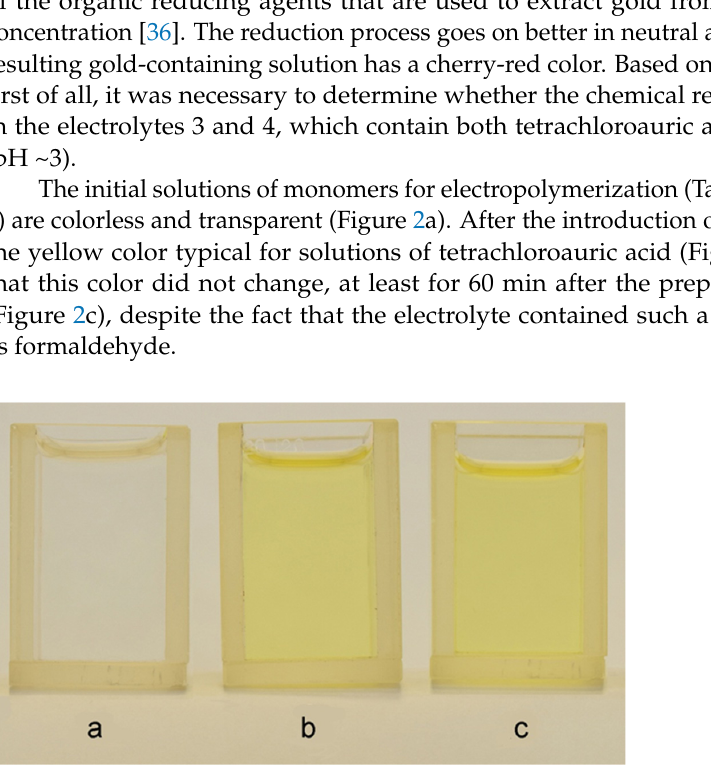
Figure 2. Color of solutions: electrolyte 2 ( a ), electrolyte 3 ( b ), electrolyte 3 after 60 min ( c ).